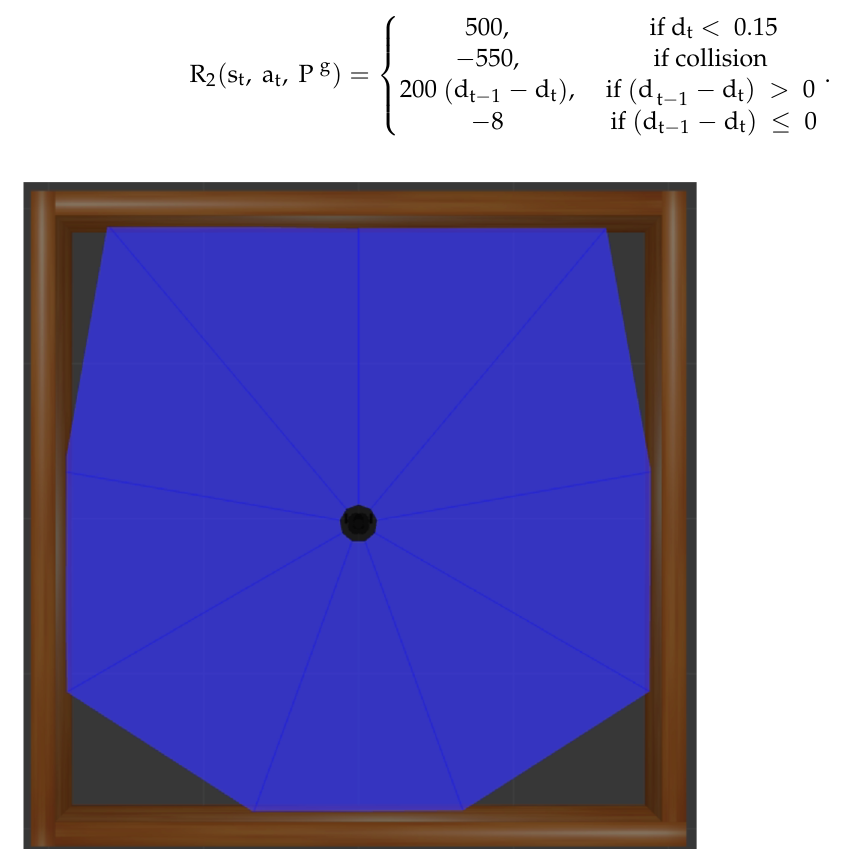
Figure 2. Laser detection range used by the robot to recognize its